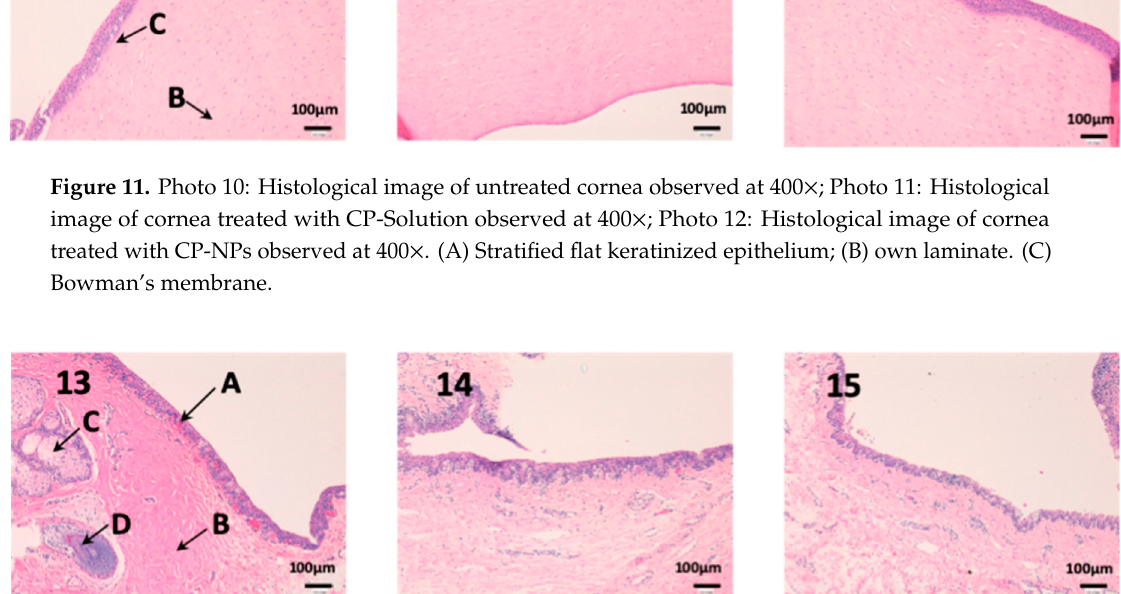
Figure 13. Photo 16: Histological image of untreated sclera observed at 400× ; Photo 17: Histological image of sclera treated with CP-Solution observed at 400× ; Photo 18: Histological image of sclera treated with CP-NPs observed at 400× . A: Stratified flat keratinized episclera; (B) stroma (collagen fibers). (C) fusca laminate (blood vessels).